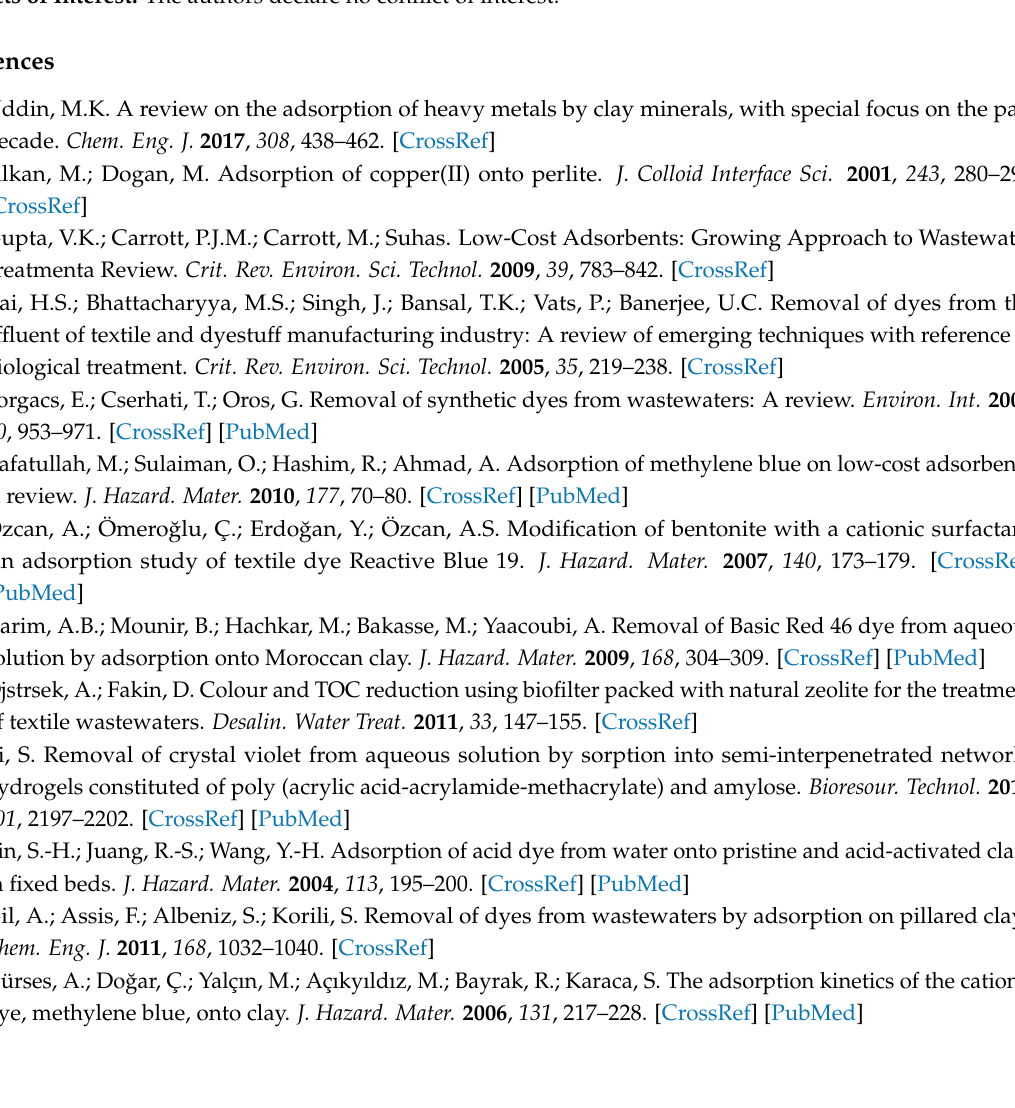
Figure S1: Behaviors of nanocomposite hydrogel after heavy metal